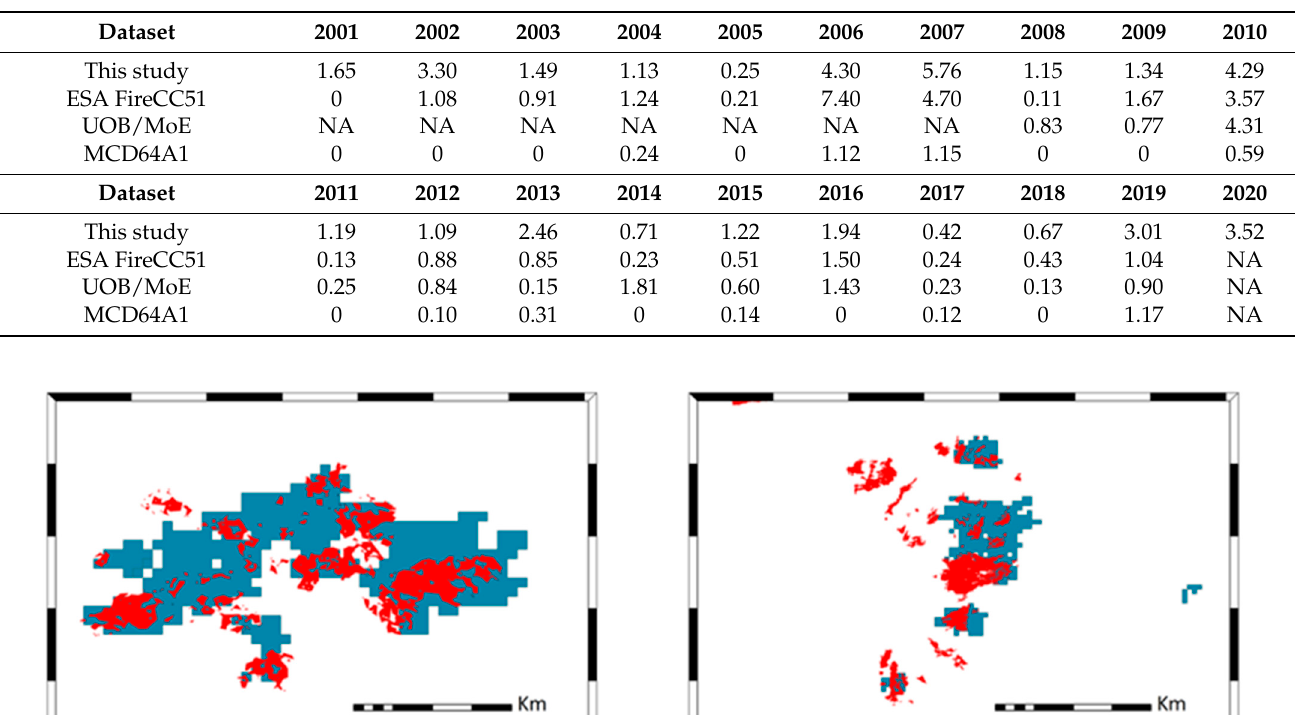
Table 4. Yearly burnt area (10 3 ha) for the period 2001–2020 in Lebanon from different sources: UOB/MoE (Adapted from http://ioe-firelab.balamand.edu.lb/pages/ProfileCountryAnnex5.aspx, accessed on 1 July 2021), ESA FireCCI51 [29,30], and MCD64A1 [28] compared to our new database. NA: unavailable data.